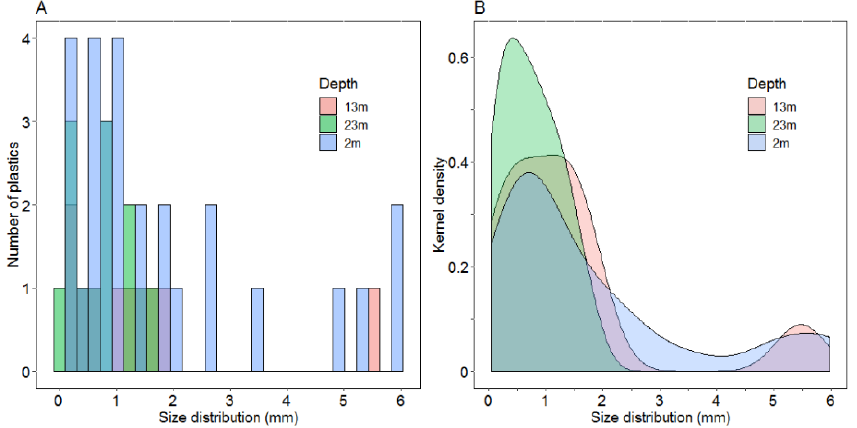
Figure 5. Size distribution ( A ) and kernel density ( B ) for plastic samples in different water depths.